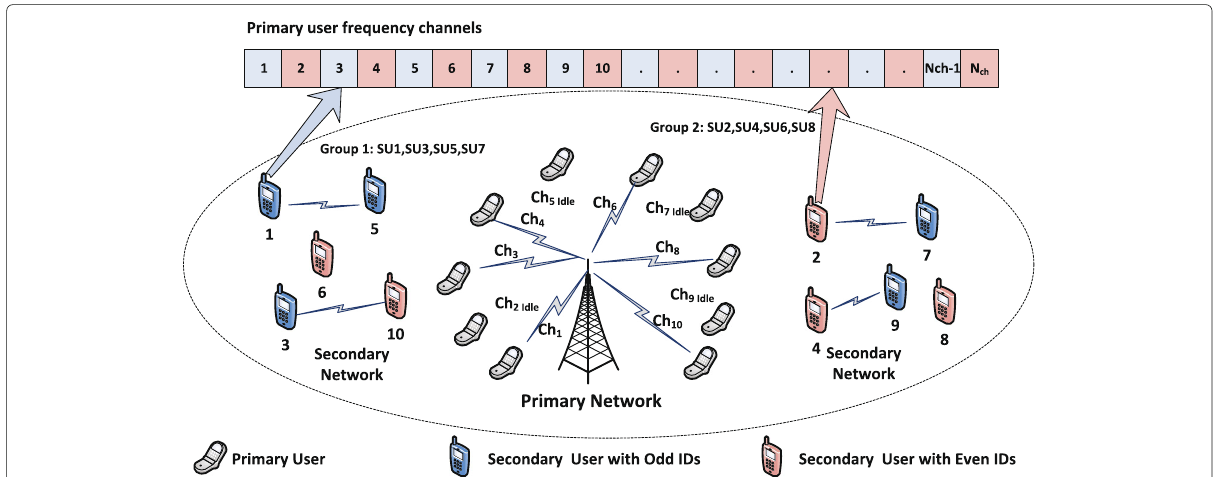
Fig. 2 The network model only showing two parallel groups based on odd and even user